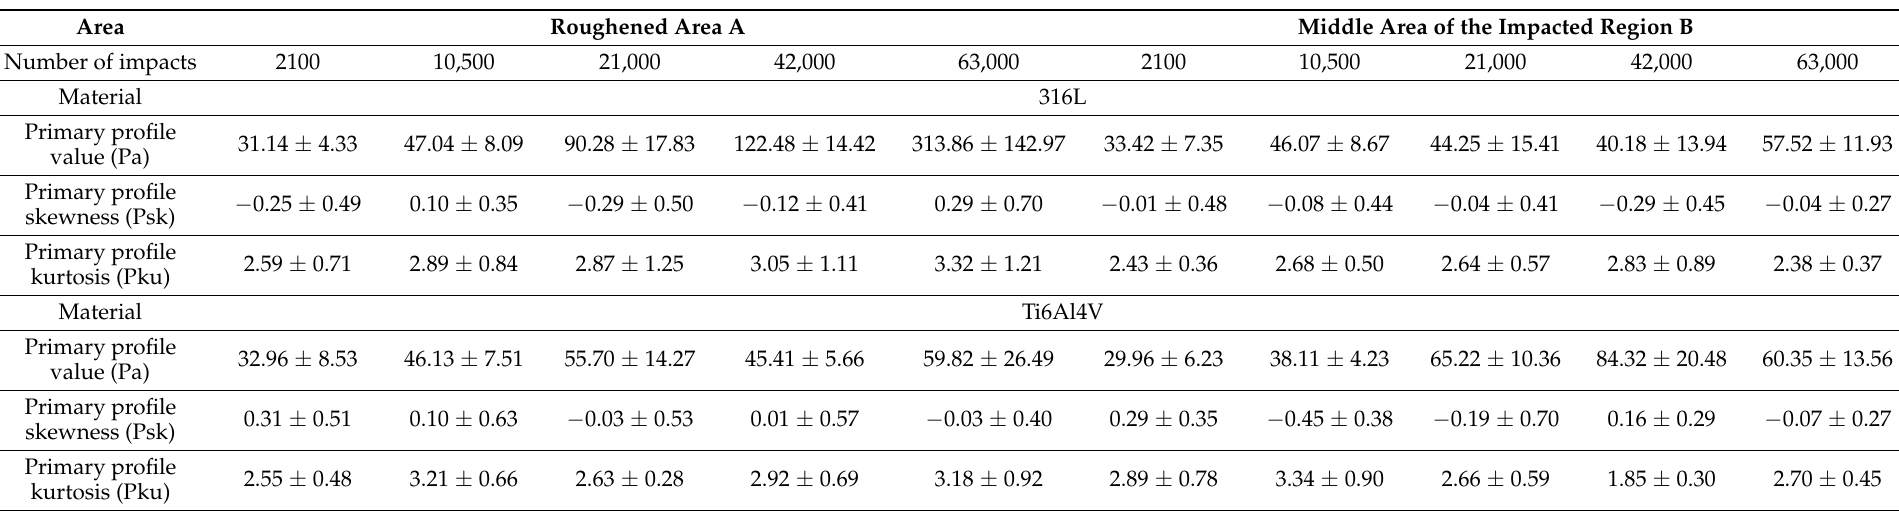
Table 5. Surface profile parameters measured in areas A and